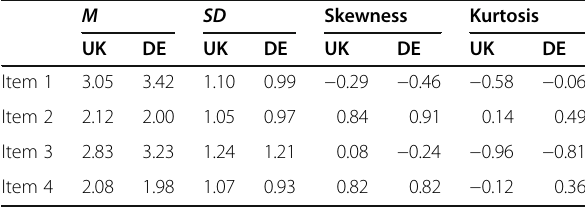
Table 3 Descriptive statistics for the PESS/PEKS items by nation M SD Skewness Kurtosis